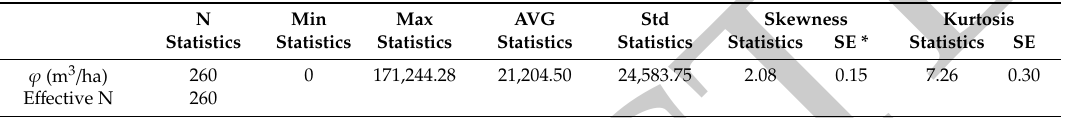
Table 1. Data-structure